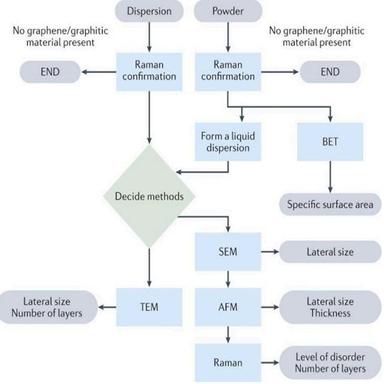
Decision flux of the measurement techniques and associated measurands for graphene from ISO/TS 21356-1:2021. This figure was reproduced with permission from.